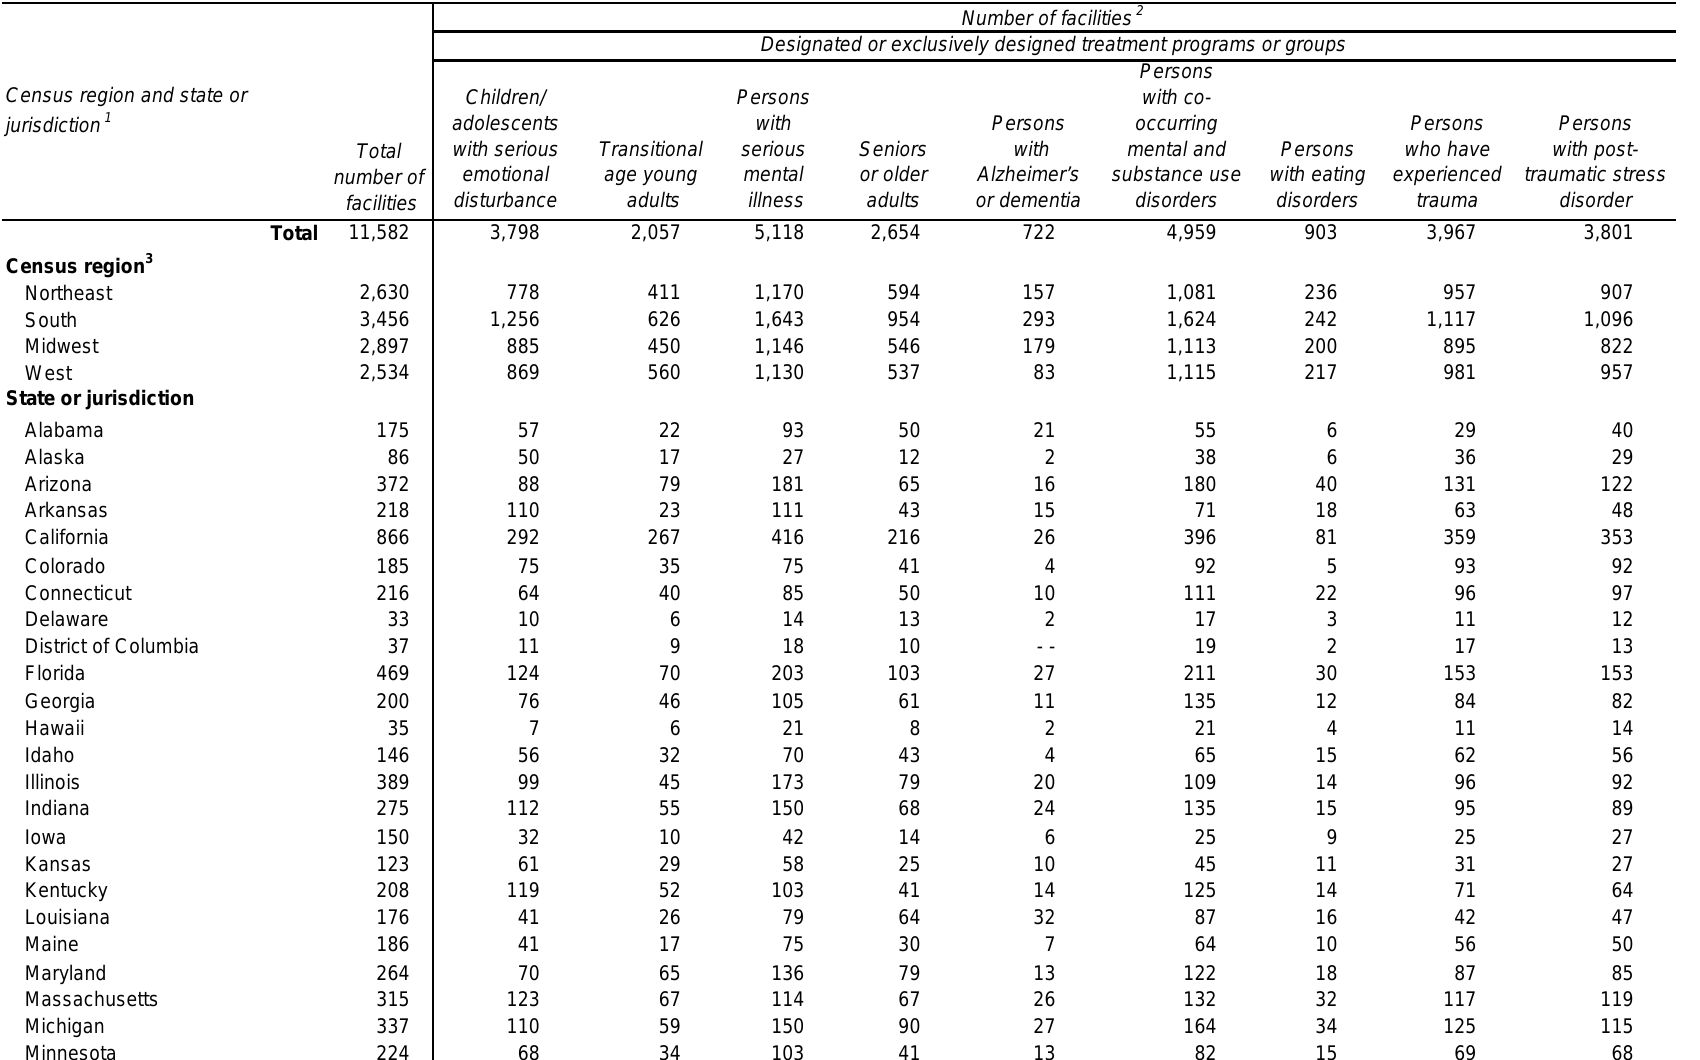
Table 3.10a. Mental health treatment facilities offering treatment programs or groups designated or designed exclusively for specific client categories,